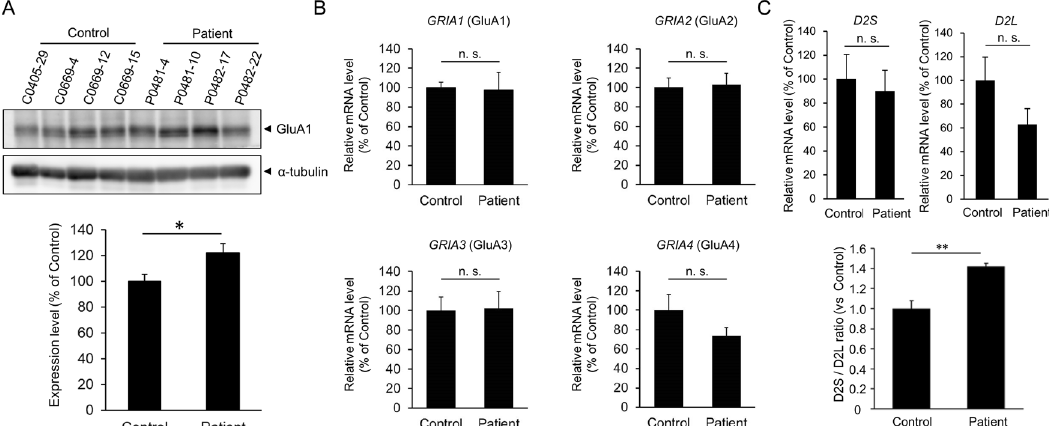
Fig. 4 Higher expression of AMPA receptors and impaired splicing of DRD2 mRNA in iPSC-derived neurons from patients. iPSC-derived neurons were cultured for 30 − 40 days for the experiments. A Protein expression levels of the GluA1 subunit of the AMPA receptor. Representative images of western blotting (upper). Quanti fi cation of protein expression levels of GluA1 (lower). Expression levels of GluA1 are normalized to those of α -tubulin ( n = 4). * P < 0.05, Student ’ s t -test. B mRNA expression levels of the subunits of the AMPA receptor. Expression levels were analyzed by quantitative real-time RT-PCR and normalized to those of GAPDH ( n = 4). n. s. not signi fi cant, Student ’ s t -test. C Increased ratio of the D2S isoform to the D2L isoform in iPSC-derived neurons from patients. Expression levels of D2S and D2L (upper). The ratio of D2S to D2L (lower). The expression levels of D2S and D2L were analyzed by quantitative real-time RT-PCR and normalized to the expression level of GAPDH ( n = 4). ** P < 0.01, Student ’ s t